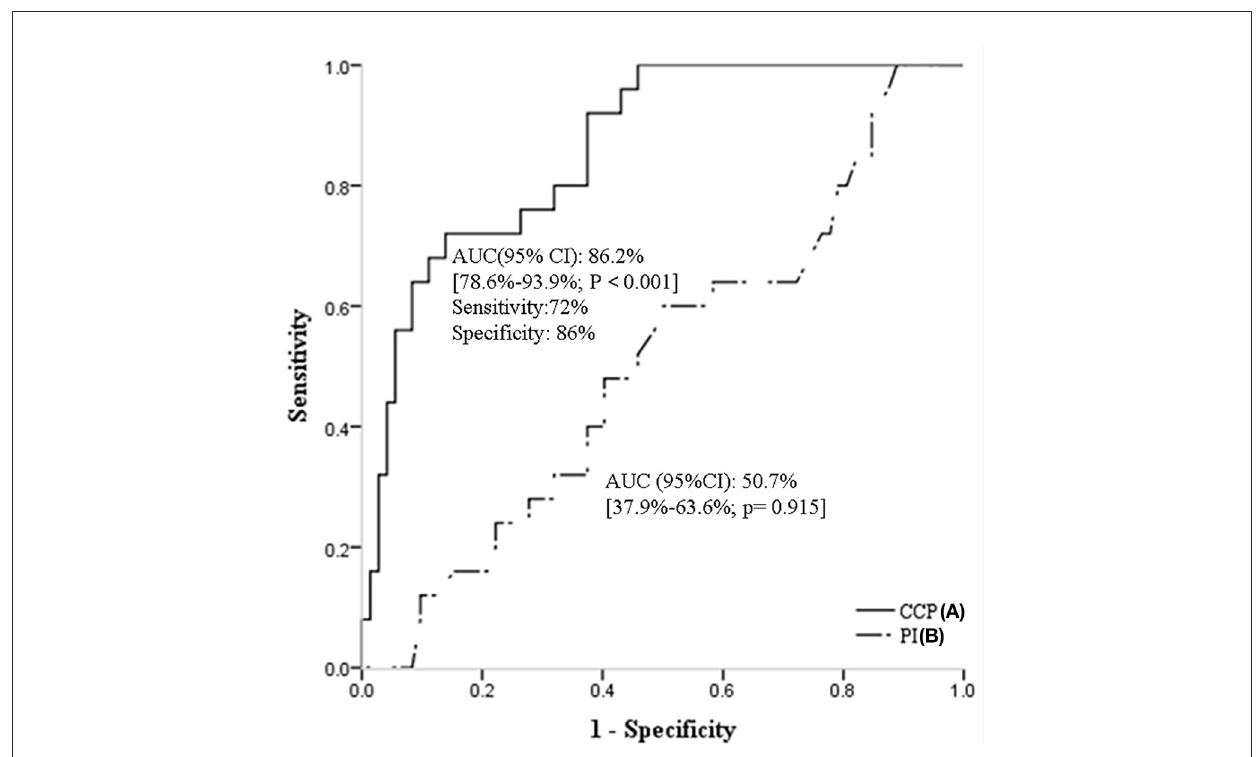
FIGURE2 Receiver operating characteristic curves of CrCP (A) , and PI (B) for predicting CSVD burden. CSVD, cerebral small vessel disease; CrCP, critical closing pressure; PI, pulsatility index.